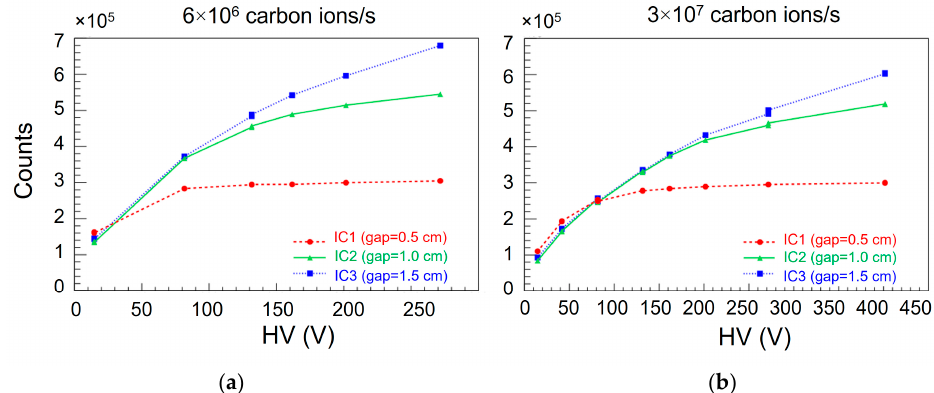
Figure 4. Integral counts measured by the three chambers as a function of the bias voltage for two beam intensities: ( a ) 6 × 10 6 and ( b ) 3 × 10 7 carbon ions/s.